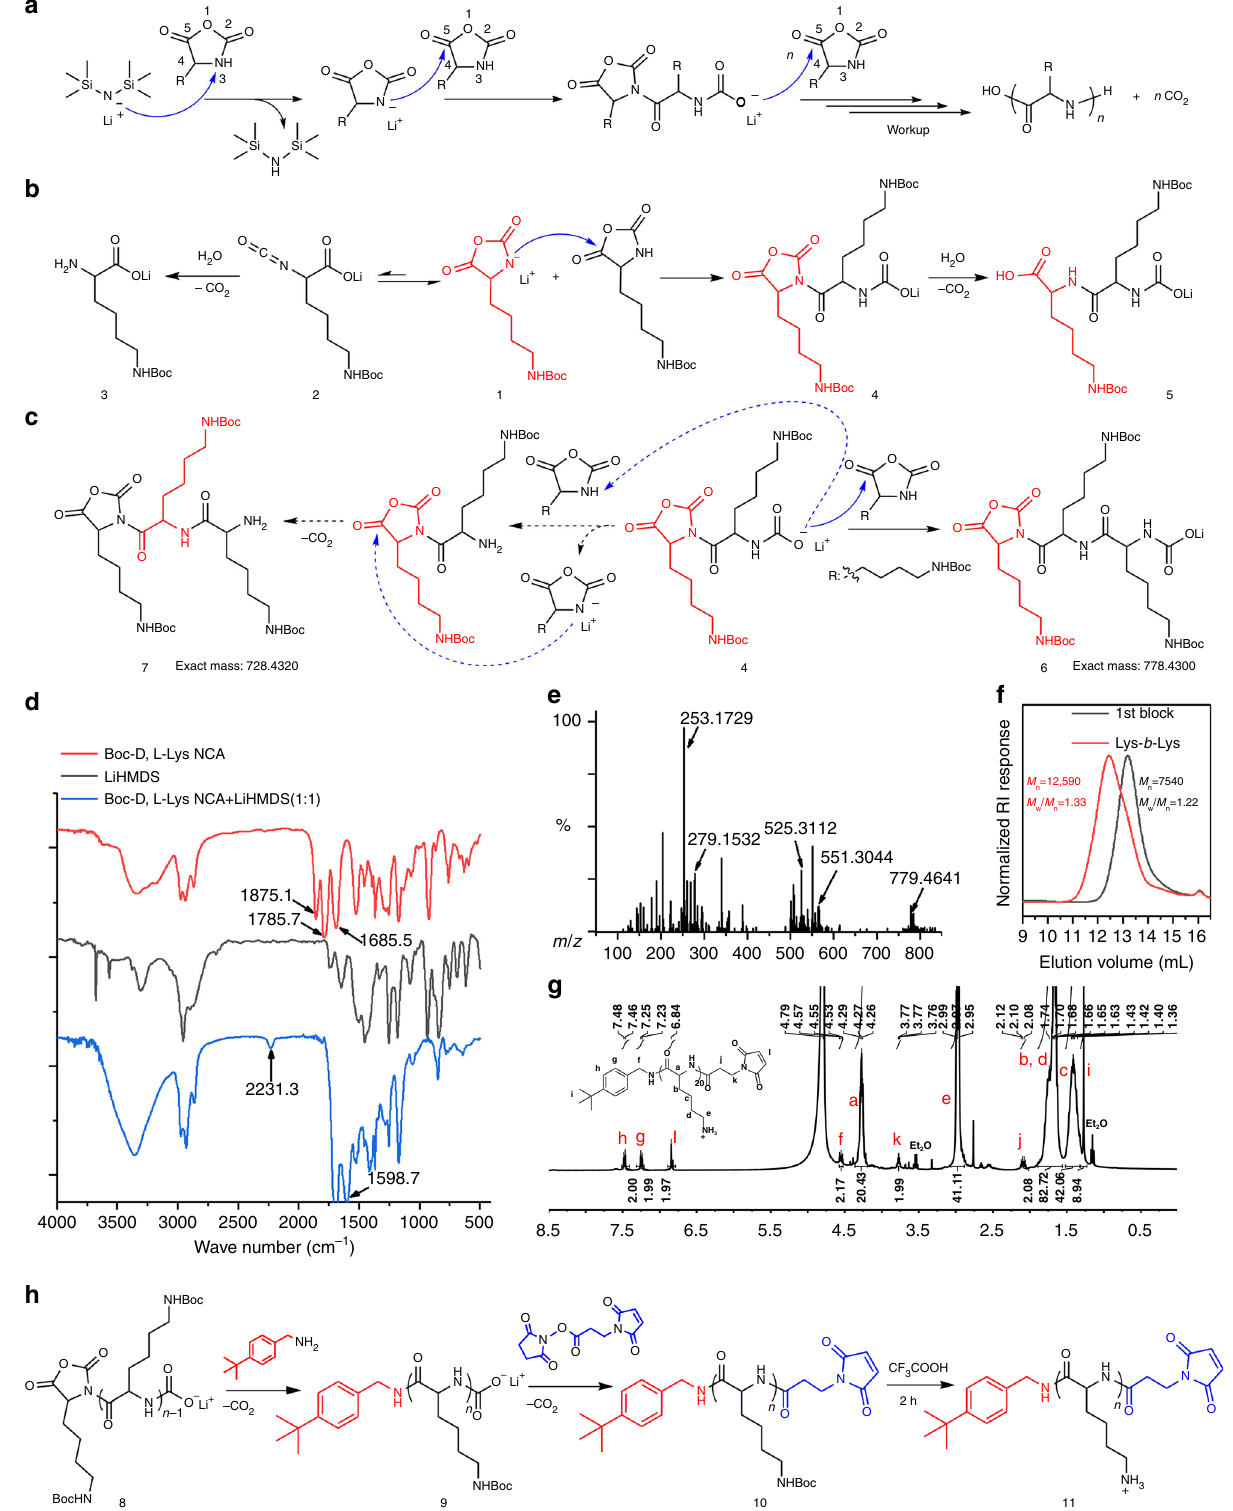
Fig. 4 Mechanism study of LiHMDS-initiated NCA polymerization. a Proposed mechanism of LiHMDS-initiated NCA polymerization; b transformation of Boc-D,L-Lys NCA in a 1:1 Boc-D,L-Lys NCA/LiHMDS mixture; c comparison between two possible chain propagation pathways; d FT-IR spectra of Boc-D,L- Lys NCA, LiHMDS and a 1:1 Boc-D,L-Lys NCA /LiHMDS mixture; e HRESI-MS analysis on a 1:1 Boc-D,L-Lys NCA/LiHMDS mixture; f GPC characterization on block co-polymer of poly(Boc-D,L-Lys)-b-poly(Boc-D,L-Lys) (Lys-b-Lys) obtained from LiHMDS-initiated polymerization of Boc-D,L-Lys NCA. Full scale GPC traces were included in the Supplementary Fig. 73-74. g Proton NMR characterization on terminal functionalization of a 20-mer polypeptide (details see Supplementary Fig. 37) 11; h reaction scheme for N-terminal and C-terminal double functionalization of a 20-mer polypeptide to give polymer 11 , where n = 20 in the reaction